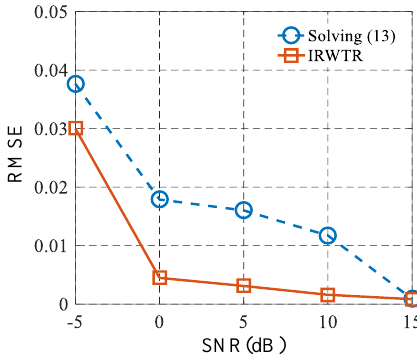
Figure 9. Performance comparison of the methods under different levels of noise.